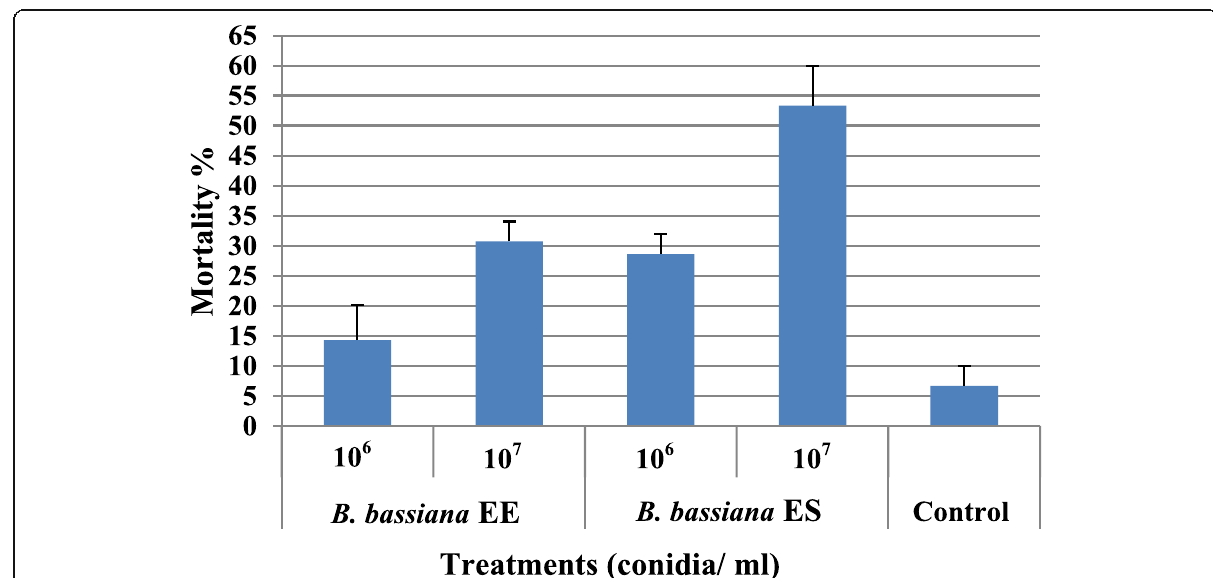
Fig. 4 Pathogenicity of Beauveria bassiana isolates to squash beetle Epilachna chrysomelina pupae, 7 days post